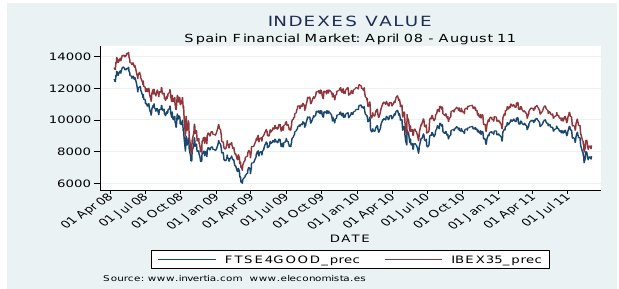
Figure 1: Daily evolution of IBEX35 and FTSE4Good